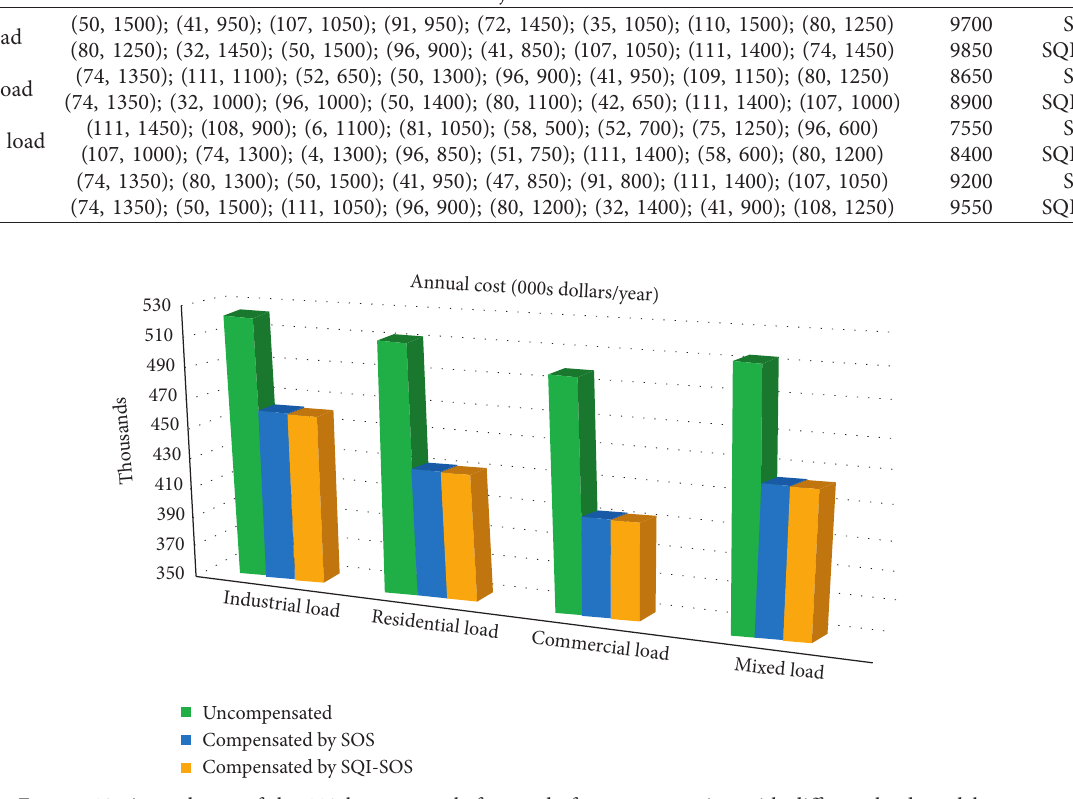
Figure 19: Annual cost of the 119-bus system before and after compensation with different load